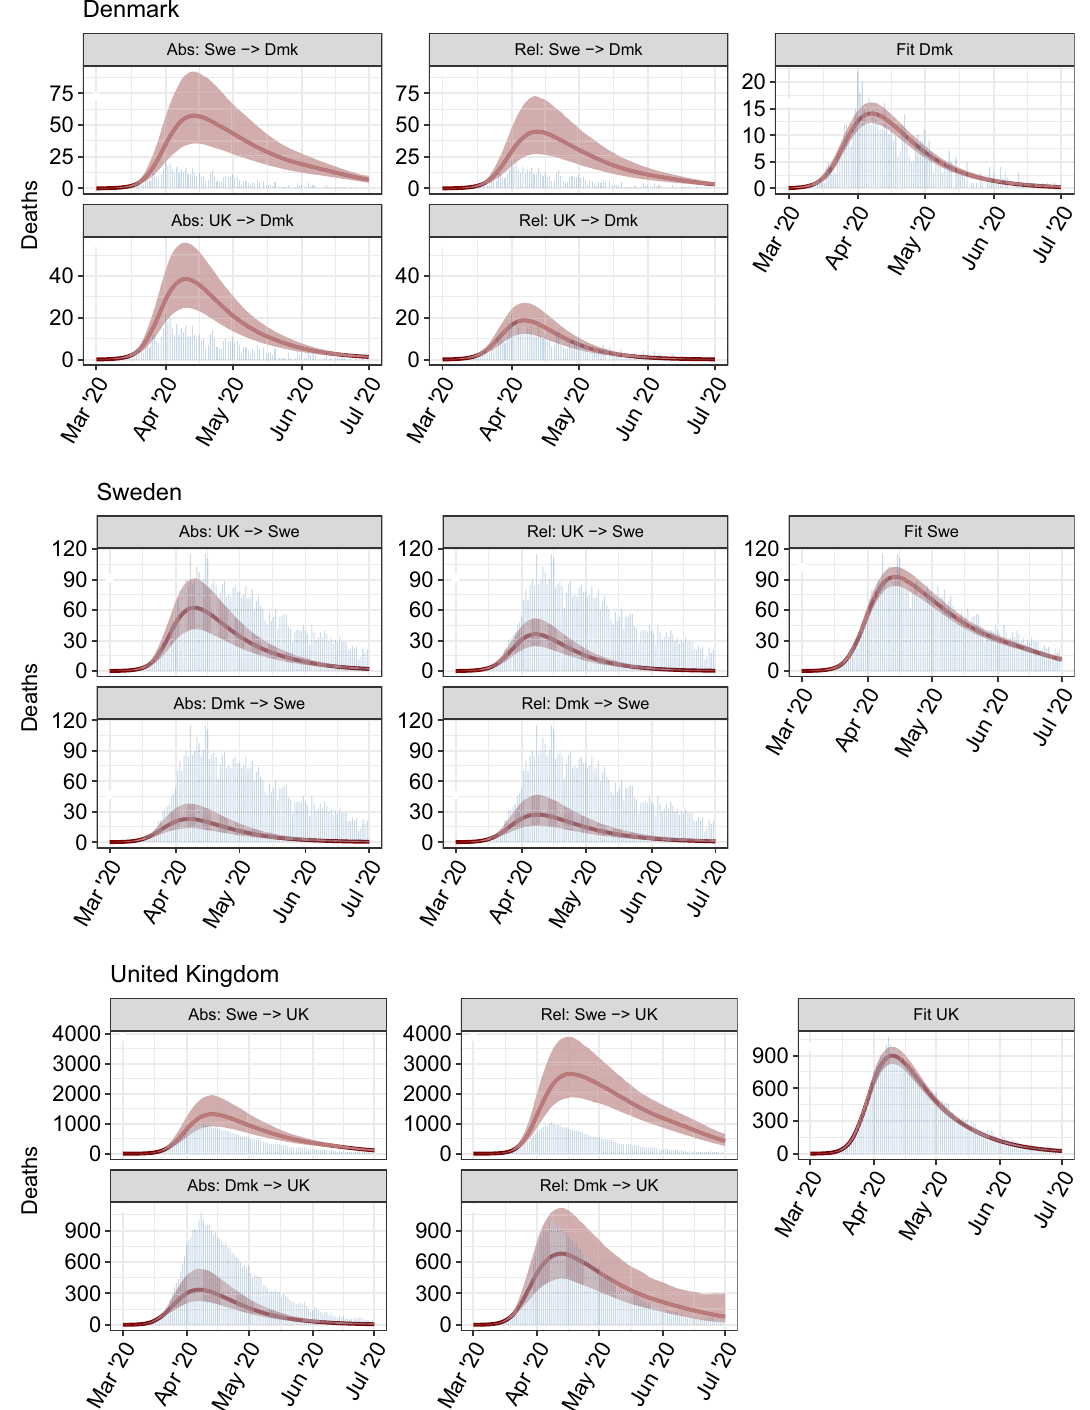
Figure 4. As per Fig. 3 but for daily deaths (red curves with shaded 95% credible intervals). Observed deaths are shown as blue